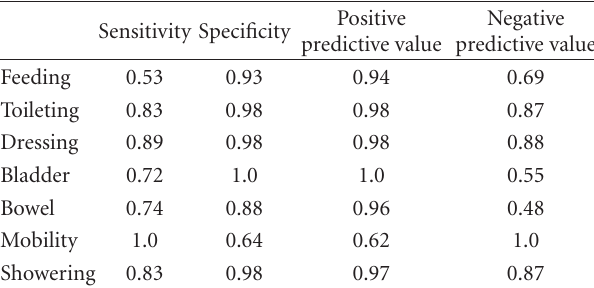
Table 1: Sensitivity, specificity, positive predictive value, and negative predictive value of the NPDS, with FIM as the golden standard.